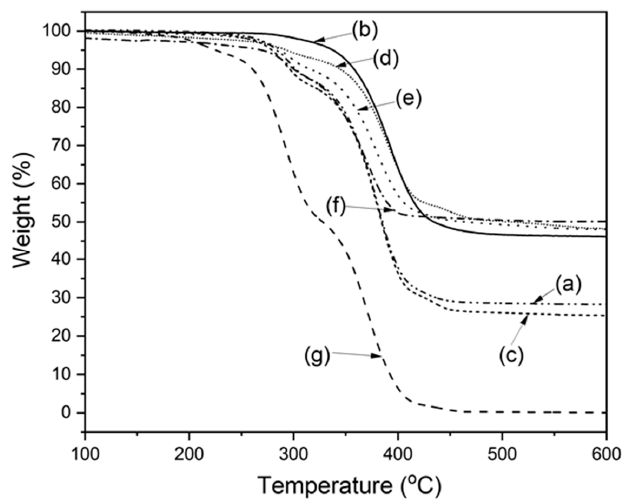
Figure 3. TGA curves of (a) 12 nm-SiO 2 (28)@PFMA, (b) 12 nm-SiO 2 (46)@PFMA, (c) 80 nm-SiO 2 (25)@PFMA, (d) 80 nm-SiO 2 (49)@PFMA, (e) 150 nm-SiO 2 (47)@PFMA, (f) 350 nm-SiO 2 (52)@PFMA, and (g) PFMA homopolymer.